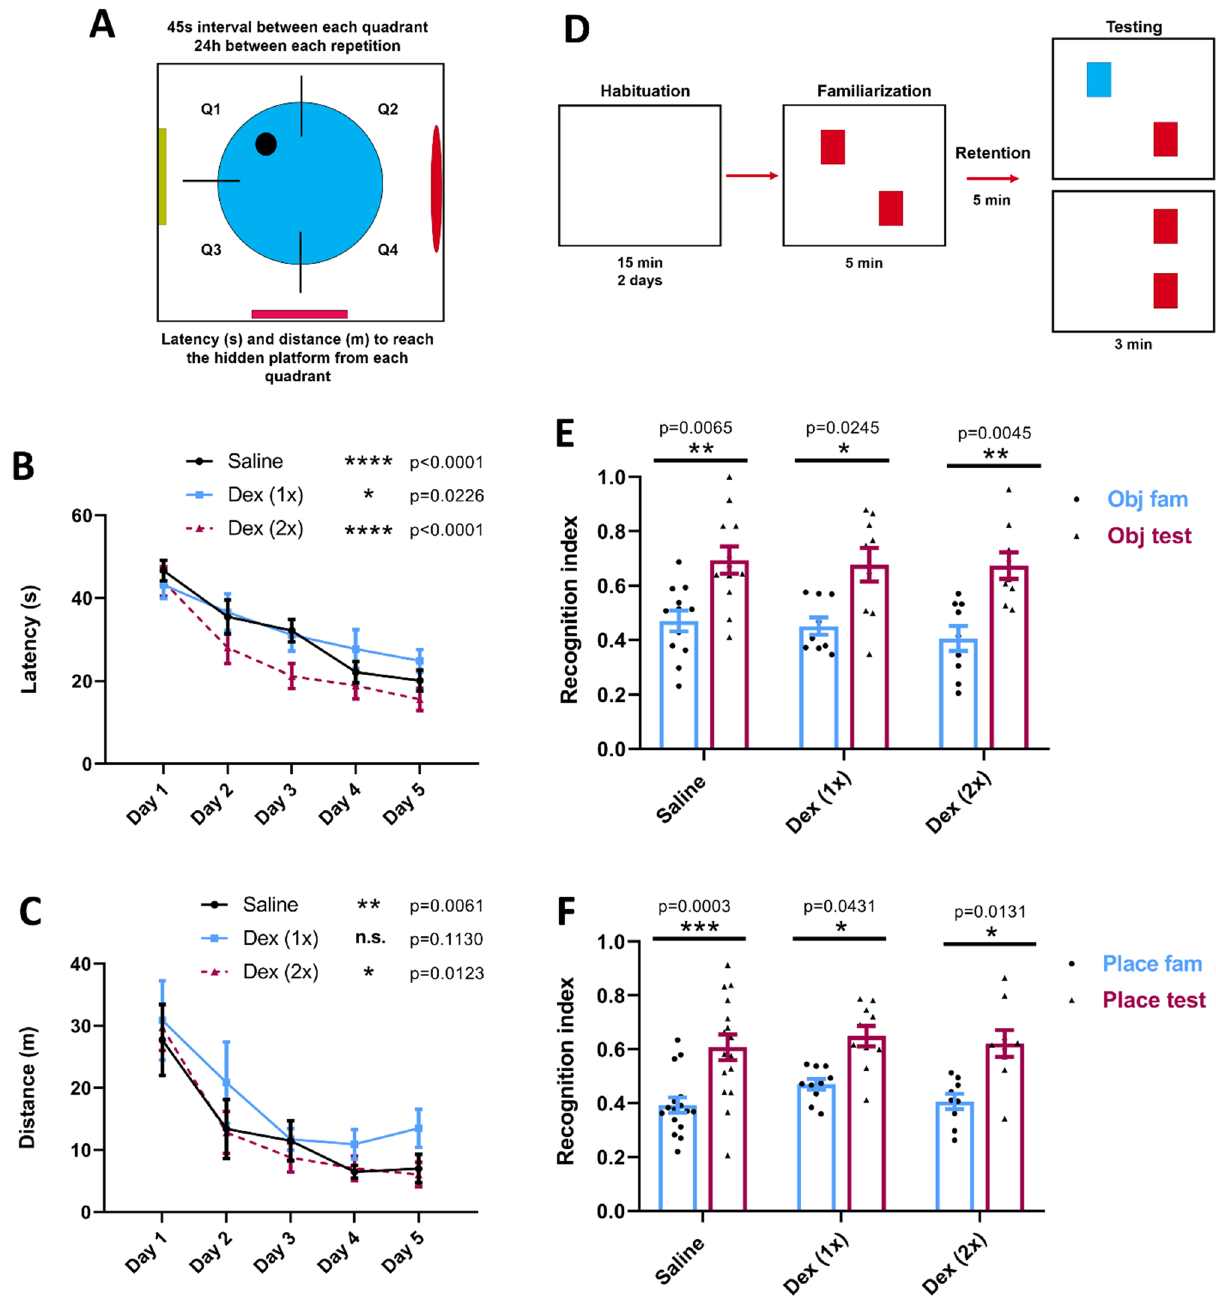
Figure 6. Dexmedetomidine did not affect cognitive capacities. ( A ) Schematic representation of Morris Water Maze protocol. ( B ) Quantification of the average latency between the 4 quadrants needed per day to reach the hidden platform; day 1: saline = 46.6 ± 2.448 (n = 16), Dex (1×) = 43.18 ± 3.325 (n = 11) and Dex (2×) = 43.99 ± 3.557 (n = 9) and day 5: saline = 20.14 ± 2.498 (n = 16), Dex (1×) = 24.83 ± 2.722 (n = 12) and Dex (2×) = 15.56 ± 2.695 (n = 9). Values are mean ± SEM F (8, 165) = 0.6369, *p = 0.0226, ****p < 0.0001 by one-way ANOVA with Tukey’s post hoc analysis for multiple comparisons. ( C ) Average swimming distance between the 4 quadrants required to reach the hidden platform; day 1: saline = 27.71 ± 5.711 (n = 13), Dex (1×) = 30.88 ± 6.356 (n = 11) and Dex (2×) = 29.74 ± 3.695 (n = 9) and day 5: saline = 6.994 ± 2.293 (n = 13), Dex (1×) = 13.48 ± 3.073 (n = 11) and Dex (2×) = 6.04 ± 1.987 (n = 9). Values are mean ± SEM F (8, 150) = 0.2167, *p = 0.0123, **p = 0.0061 by one-way ANOVA with Tukey’s post hoc analysis for multiple comparisons. ( D ) Schematic representation of Novel Object Recognition tests. ( E ) Recognition index calculated as the time spent with the novel object (TN) divided by the total time spent with both objects (TN + TF); familiarization: saline = 0.4698 ± 0.0384 (n = 11), Dex (1×) = 0.451 ± 0.0322 (n = 9) and Dex (2×) = 0.405 ± 0.0457 (n = 9) and testing: saline = 0.694 ± 0.0496 (n = 12), Dex (1×) = 0.677 ± 0.0624 (n = 9) and Dex (2×) = 0.674 ± 0.04815 (n = 9). Values are mean ± SEM F (2, 54) = 0.136, *p = 0.0245, **p = 0.045 and **p = 0.0065 by one-way ANOVA with Tukey’s post hoc analysis for multiple comparisons. ( F ) Recognition index calculated as the time spent with the object located in a different place (TN) divided by the total time spent with both objects (TN + TF); familiarization: saline = 0.393 ± 0.0283 (n = 16), Dex (1×) = 0.471 ± 0.01996 (n = 10) and Dex (2×) = 0.406 ± 0.0285 (n = 9) and testing: saline = 0.608 ± 0.0475 (n = 16), Dex (1×) = 0.649 ± 0.038 (n = 10) and Dex (2×) = 0.622 ± 0.0502 (n = 9). Values are mean ± SEM F (2, 64) = 0.1315, *p = 0.0131 and *p = 0.043, ***p = 0.0003 by one-way ANOVA with Tukey’s post hoc analysis for multiple comparisons. Bars indicate ±